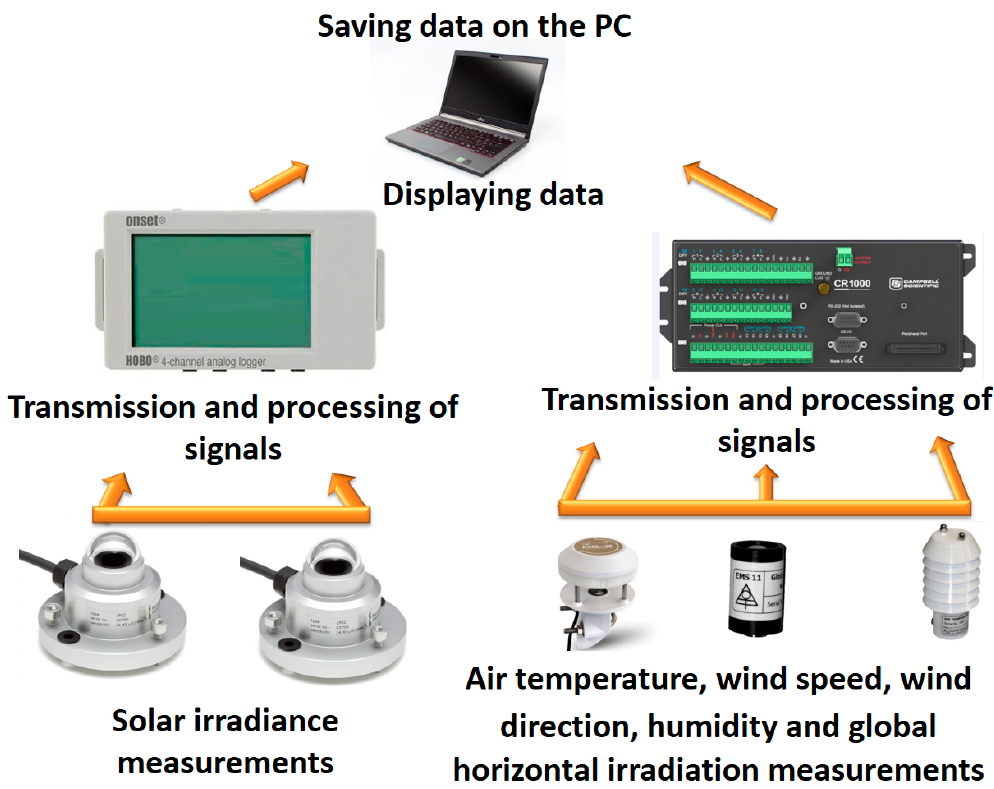
Figure 5. The configuration of PV module measuring station ‘B’.